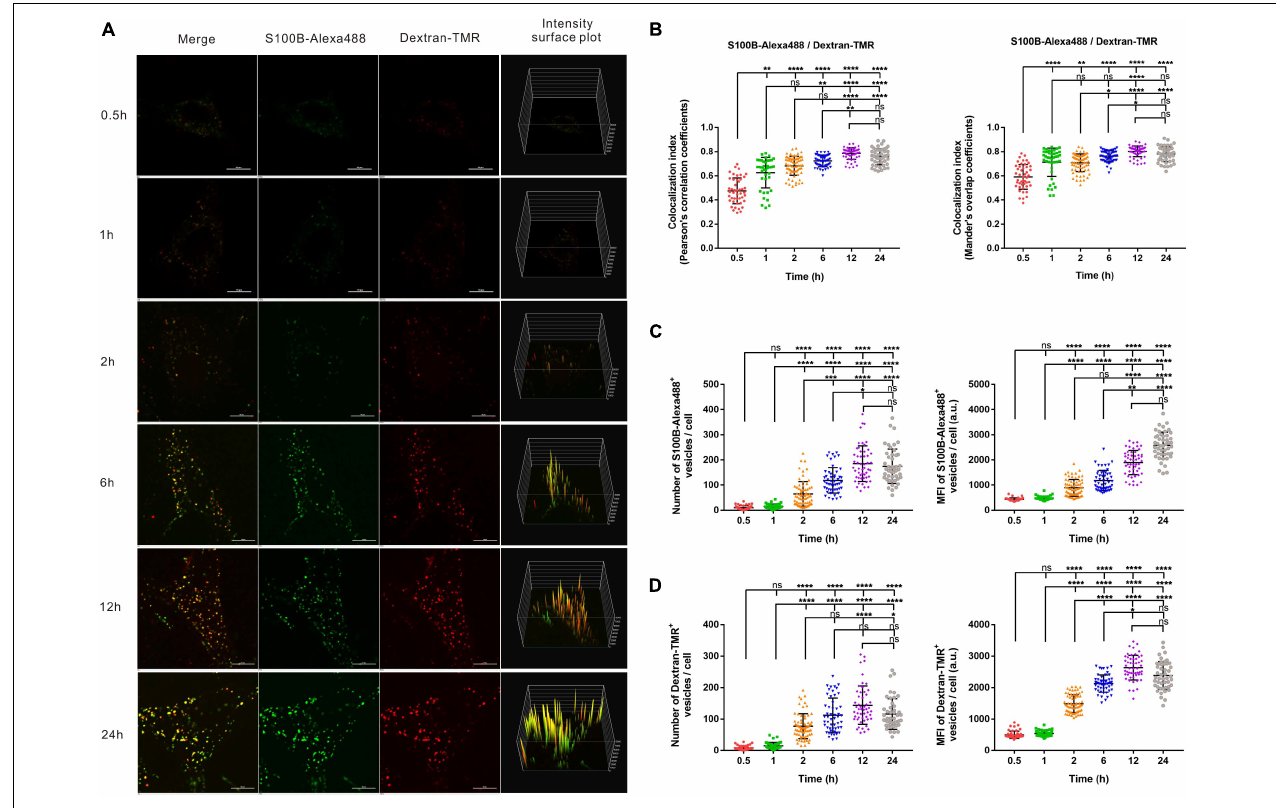
FIGURE 3 | Time-dependent endocytosis of S100B-Alexa488 and Dextran-TMR into MSCs. Cells were incubated with S100B-Alexa488 (0.1 µ M) and Dextran-TMR (0.05 mg/ml) simultaneously for the indicated time periods. (A) Representative live cell confocal images. Scale bar, 10 µ m. (B–D) Quantified data (analyzed as described in section “Materials and Methods”) of the indicated time points showing (B) the colocalization index (the Pearson’s correlation coefficients and the Mander’s overlap coefficients) of S100B-Alexa488 and Dextran-TMR, the number and mean fluorescence intensity (MFI) of (C) S100B-Alexa488- and (D) Dextran-TMR-positive vesicles. Data are presented as the means + SD in (B) and as the median and interquartile range (IQR) in C,D , n (0.5 h) = 46 cells; n (1 h) = 41 cells; n (2 h) = 68 cells; n (6 h) = 52 cells; n (12 h) = 52 cells; n (24 h) = 47 cells. All the experiments were repeated for three times. Asterisks indicate statistical significance between the indicated groups: * P < 0.05, ** P < 0.01, *** P < 0.001, **** P < 0.0001, ns, not